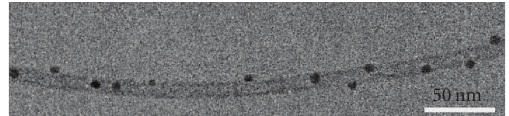
Figure 5: Cryo-TEM image of C8S3 aggregates after addition of AgNO 3 and reducing agent. [C8S3] = 5 × 10 − 4 mol · l − 1 in water and 15wt % MeOH; [AgNO 3 ] = 2 . 1 × 10 − 5 mol · l − 1